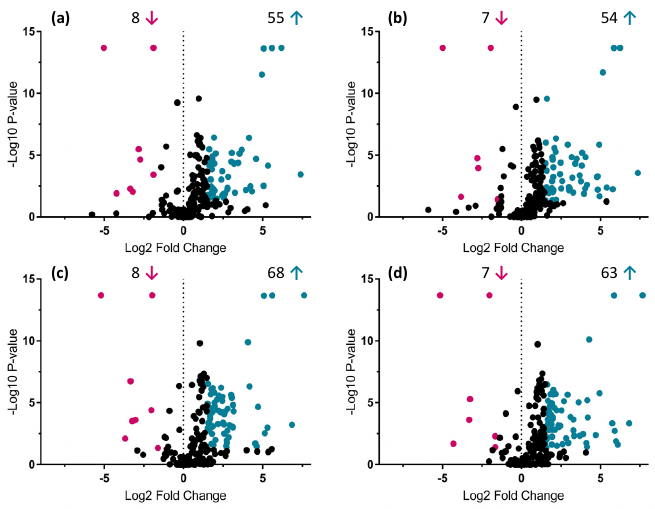
Figure 3. Volcano-plot analysis—Identification of up- and down-regulated compounds ( p -value < 0.05 and fold change > 1.5) between A. officinalis shoot samples associated with four AMF species